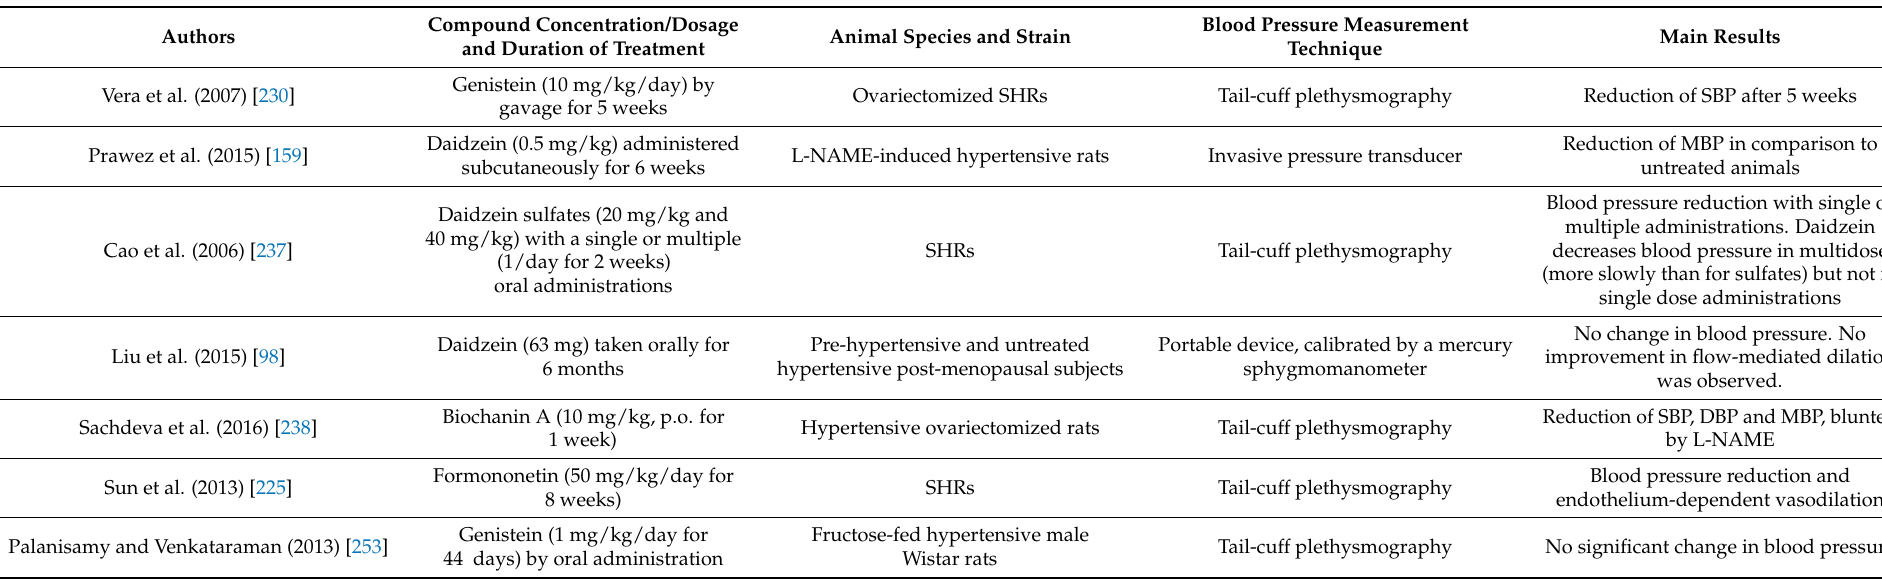
Table 7. Description and main results of in vivo studies on the blood pressure-lowering effects of isolated isoflavones or isoflavone-containing products (SBP—systolic blood pressure, DBP—diastolic blood pressure, MBP—mean blood